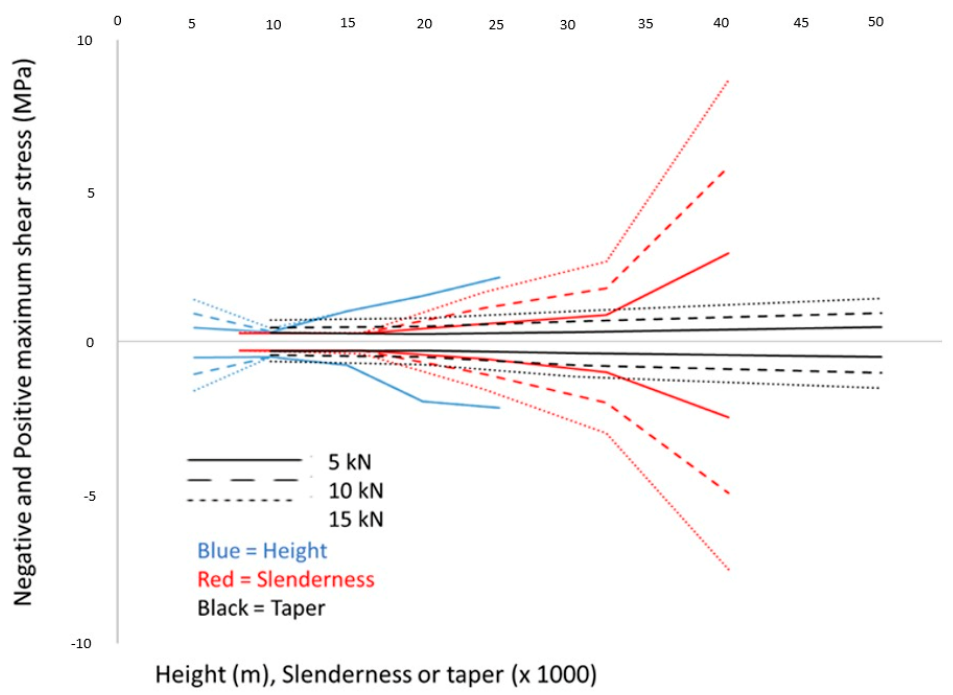
Figure 7. Behavior variation of the maximum positive and negative shear stresses versus tree height (m), slenderness, and taper ( × 1000) for the three levels of simulated horizontal forces (5 kN, 10 kN and 15 kN). Table 8. Regression models considering maximum (negative and positive) shear stresses ( τ ) as a function of height ( H ), slenderness ( λ ), and taper ( T × 10 2 ) for each level of horizontal load adopted. Variables